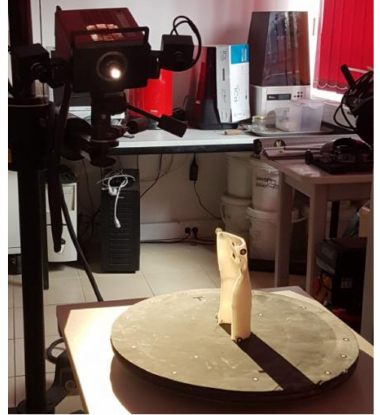
Figure 6. Measurement of an orthosis with a 3D